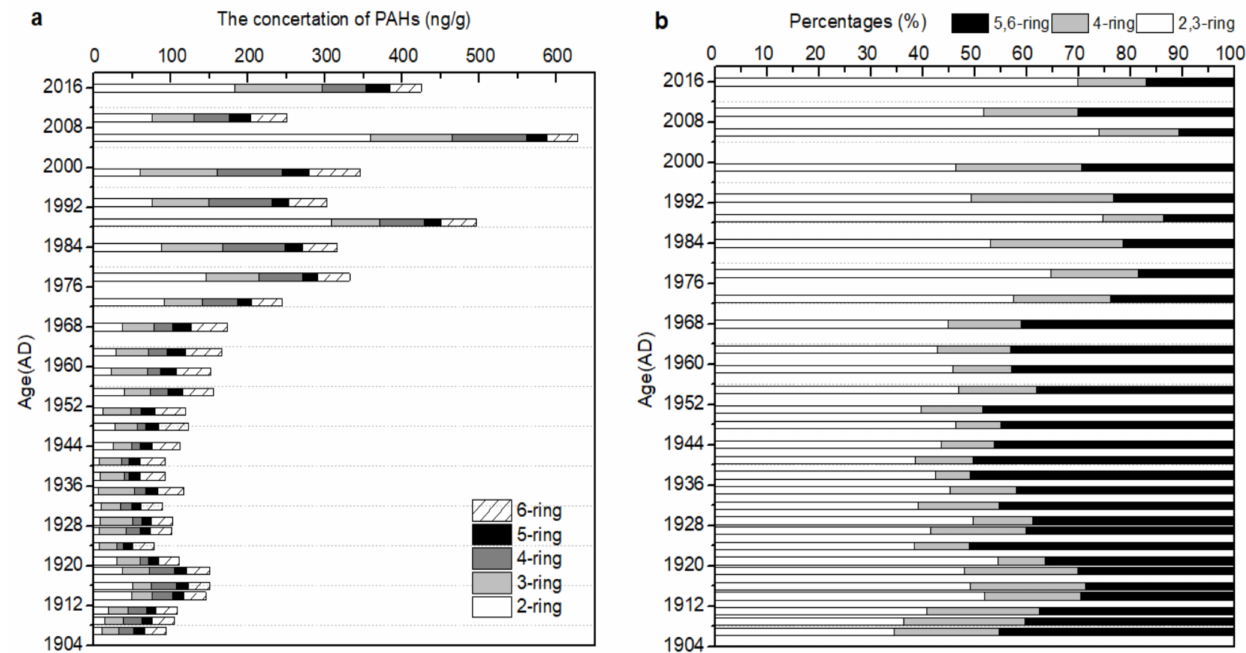
Figure 3. The historical variations of the concentrations ( a ) and percentages ( b ) of polycyclic aromatic hydrocarbons (PAHs) with different rings (2–6 rings) in the sediment core of Dongping Lake. Two-ring PAHs include Naph; three-ring PAHs include Aceph, Ace, Fl, Phen, and Ant; four-ring PAHs include Flu, Pyr, BaA, and Chr; five-ring PAHs include BbF, BkF, BaP, and DBA; six-ring PAHs include InP and